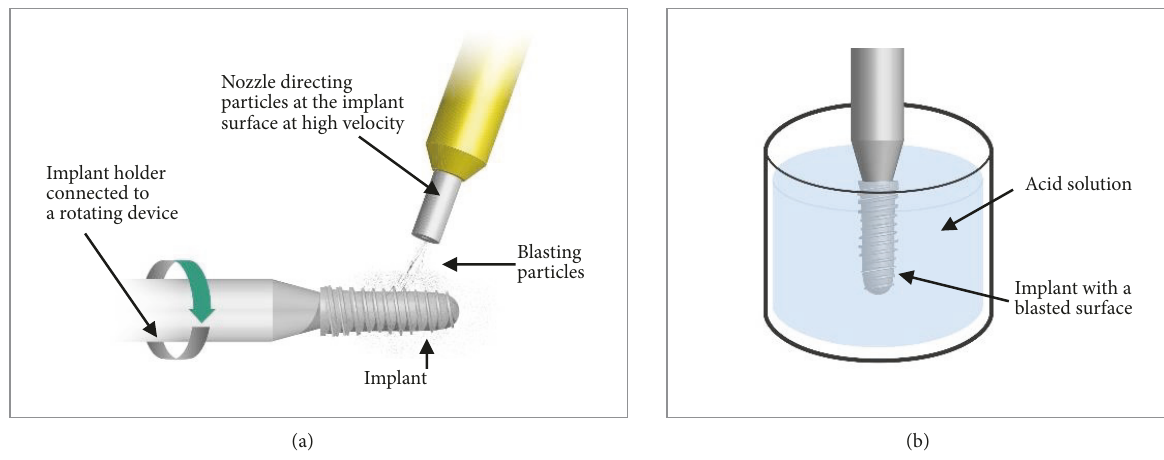
Figure 1: Schematic representation of the sandblasting (a) and acid-etching process